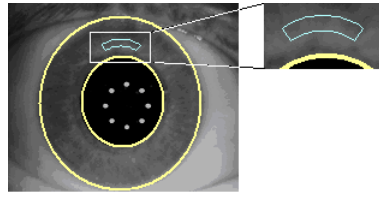
Figure 7. Digital iris code performance .